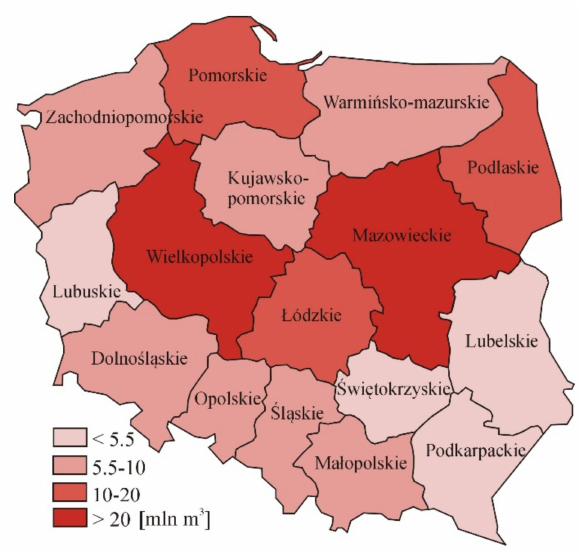
Figure 7. The volume of BM that can be obtained from biodegradable waste from the agri-food industry in Poland (mln m 3